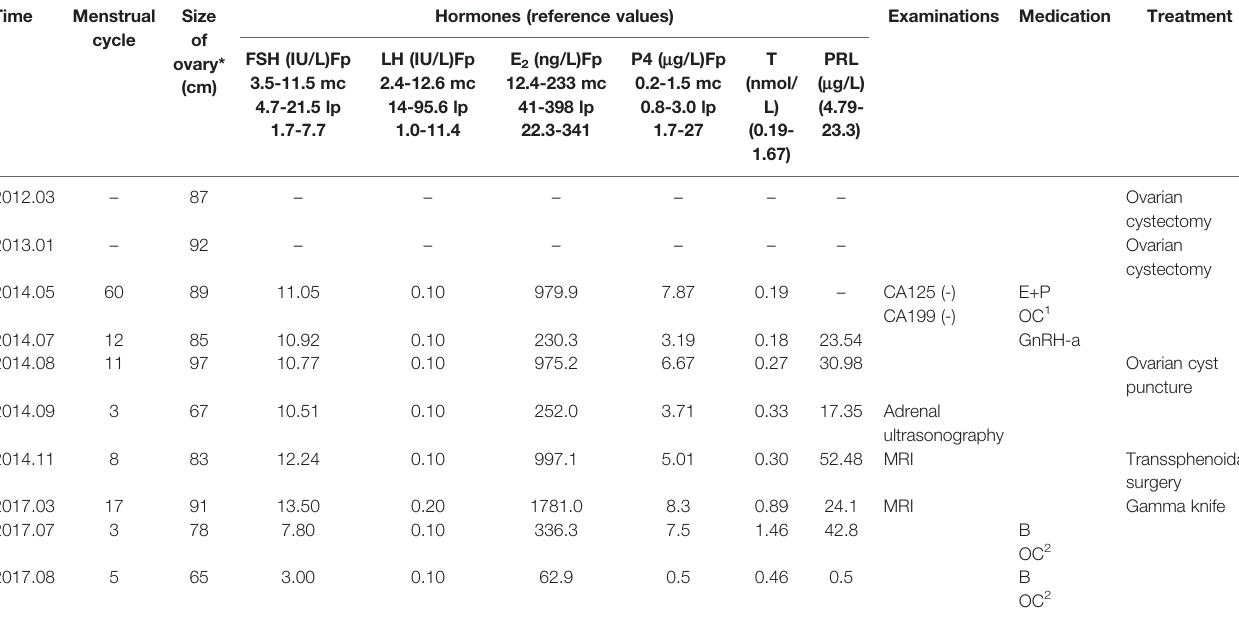
TABLE 1 | Clinical characteristics and treatment of this patient. Time Menstrual Size cycle of